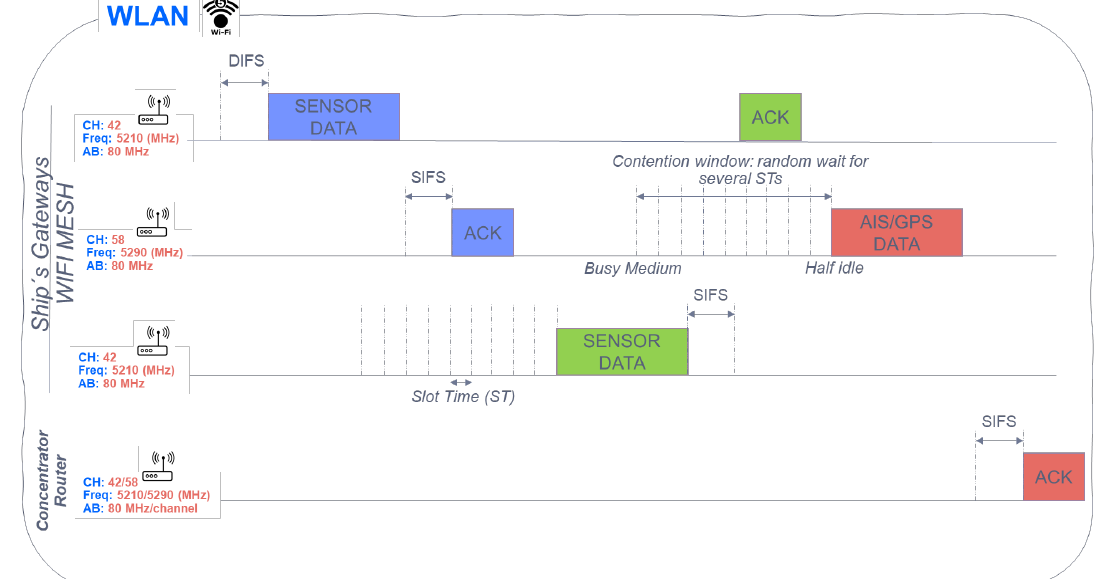
Figure 14. Sensor data sending detail, AIS, GPS in WLAN.